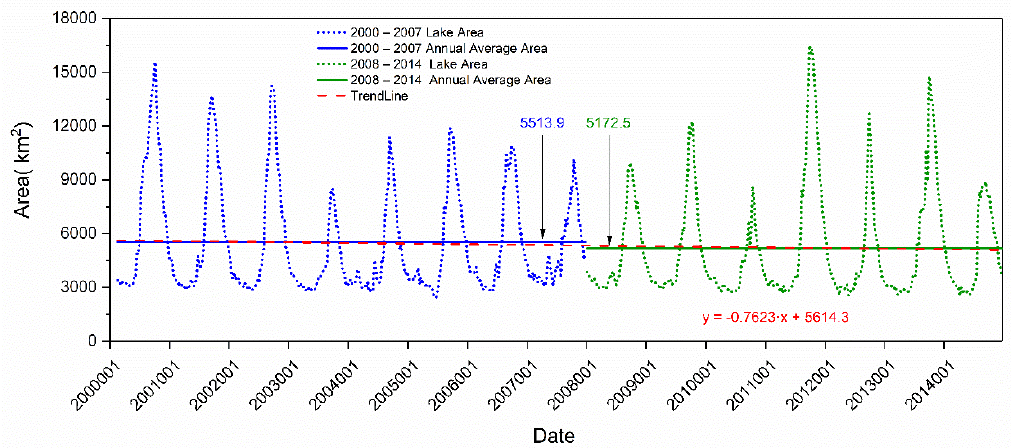
Figure 2. Variation in the Water Area of Tonle Sap Lake from 2000 to 2014 (For the MOD09A1 image can be obtained every 8 days and 46 images per year, we collected a total of 683 images (h28v07) from DOY2000049 to DOY2014361. Due to the image in DOY2000169 for h28v07 is not available, the missing value was filled by interpolation.).